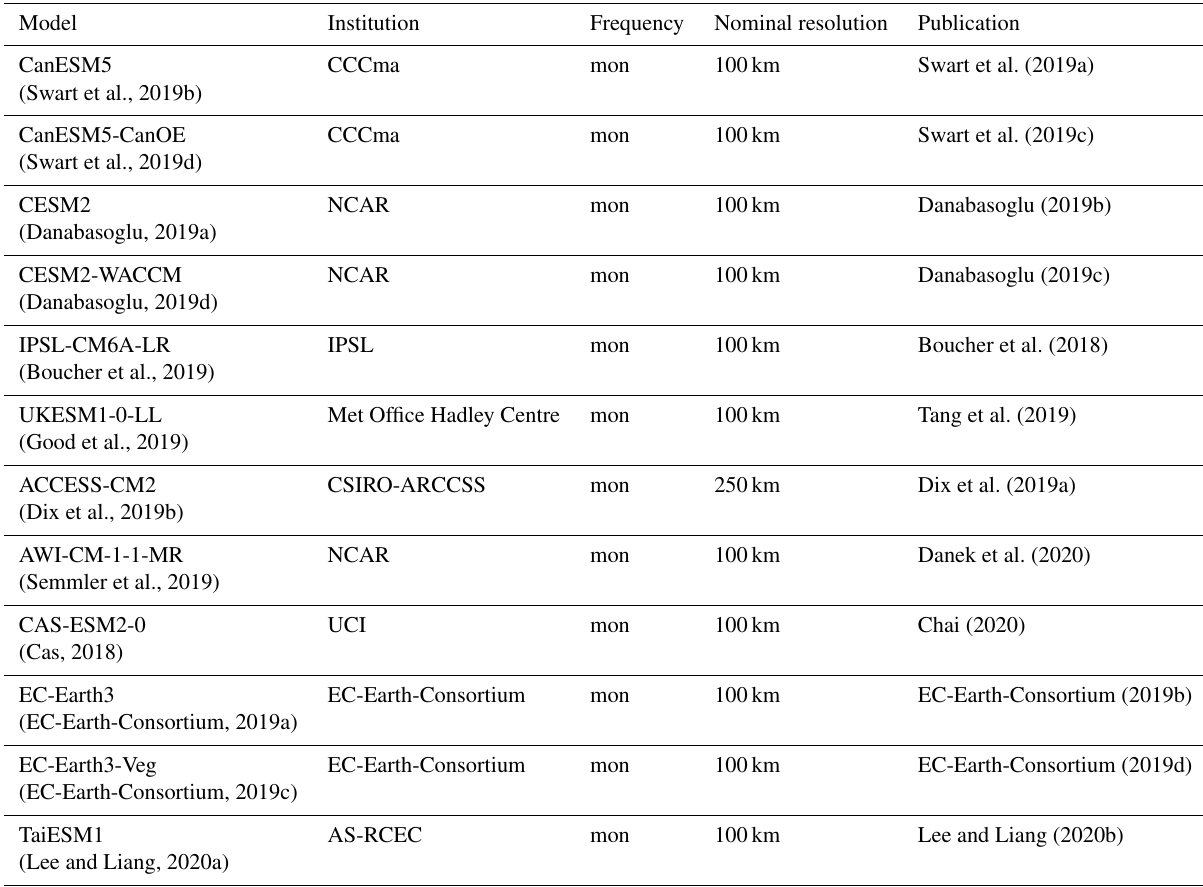
Table 3. Details of the models used in this study.